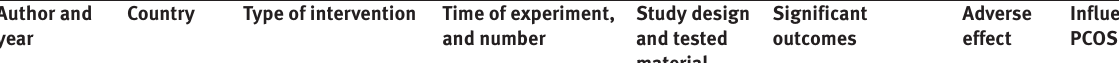
numberType of interventionCountryAuthor and